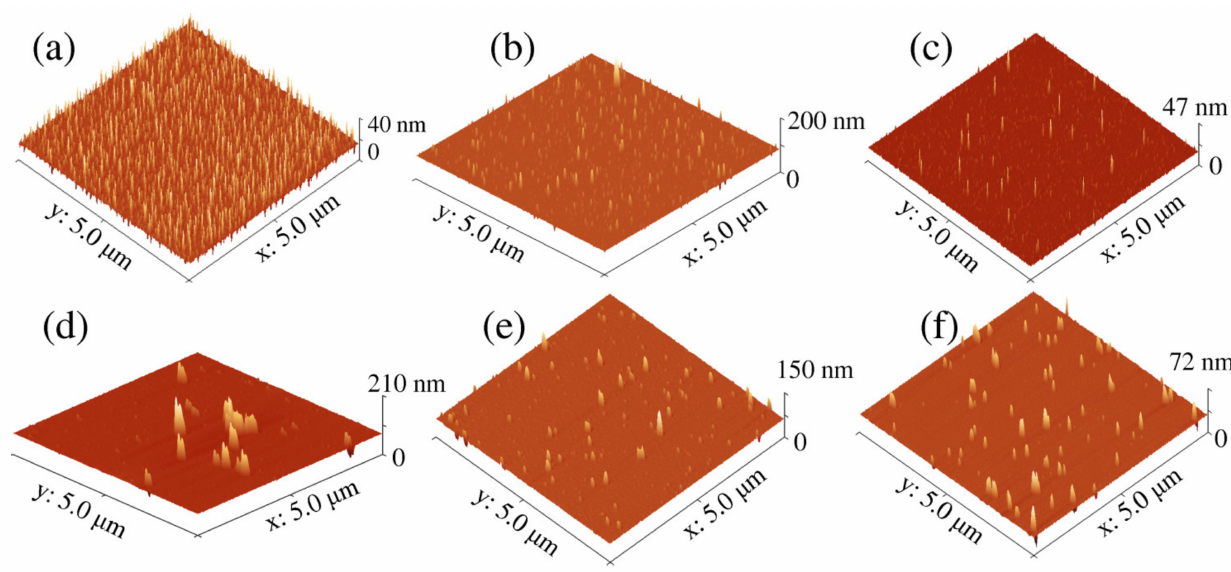
Figure 3. AFM images of p-GQDs ( a ), 25 GQD IPA -EDA ( b ), 50 GQD IPA -EDA ( c ), 200 GQD IPA -EDA ( d ), 200 GQD-5EDA ( e ), and 200 GQD-10EDA ( f ). In Table 1, the values of average lateral size and height for GQDs samples are presented. It can be observed that both height and diameter increased with gamma-irradiated